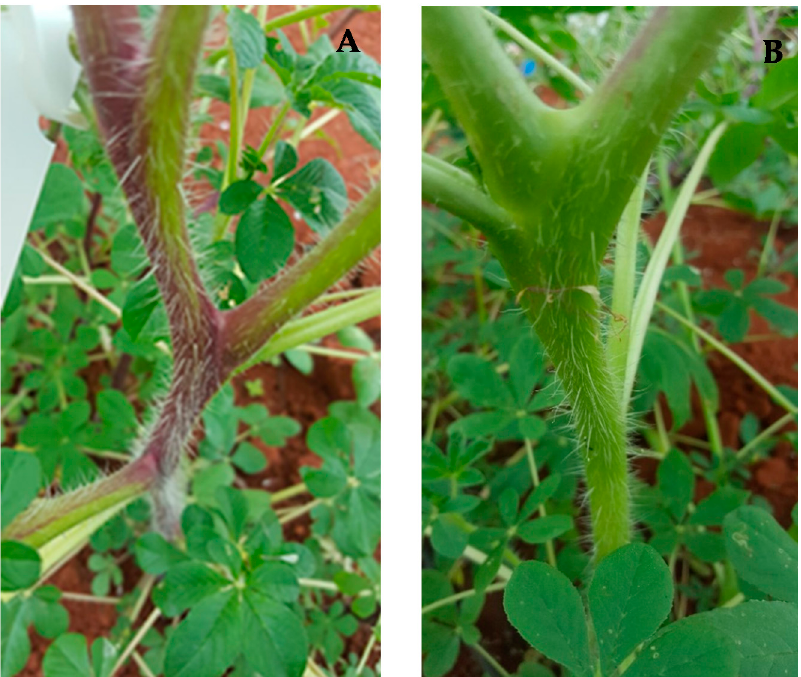
Figure 1. An example of variation in stem colour (( A ) = purple and ( B ) = green) among the accessions.